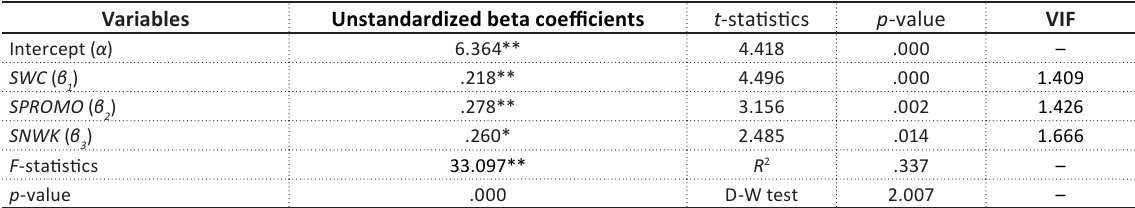
Table 4. Multiple regression equation of NC on all